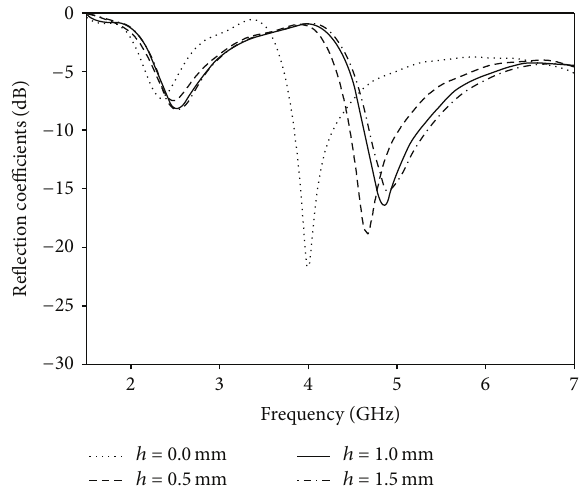
Figure 2: Simulated reflection coefficients of a two-strip monopole antenna as a function of height ℎ .